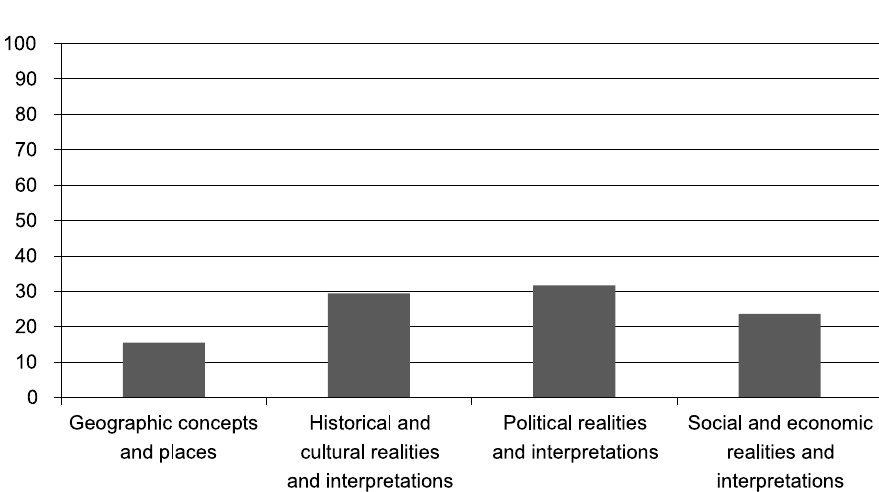
Fig. 2. Percentage distribution in semantic fields of the words shaping the concept of Europe after an associated word test on students in training to be teachers in secondary